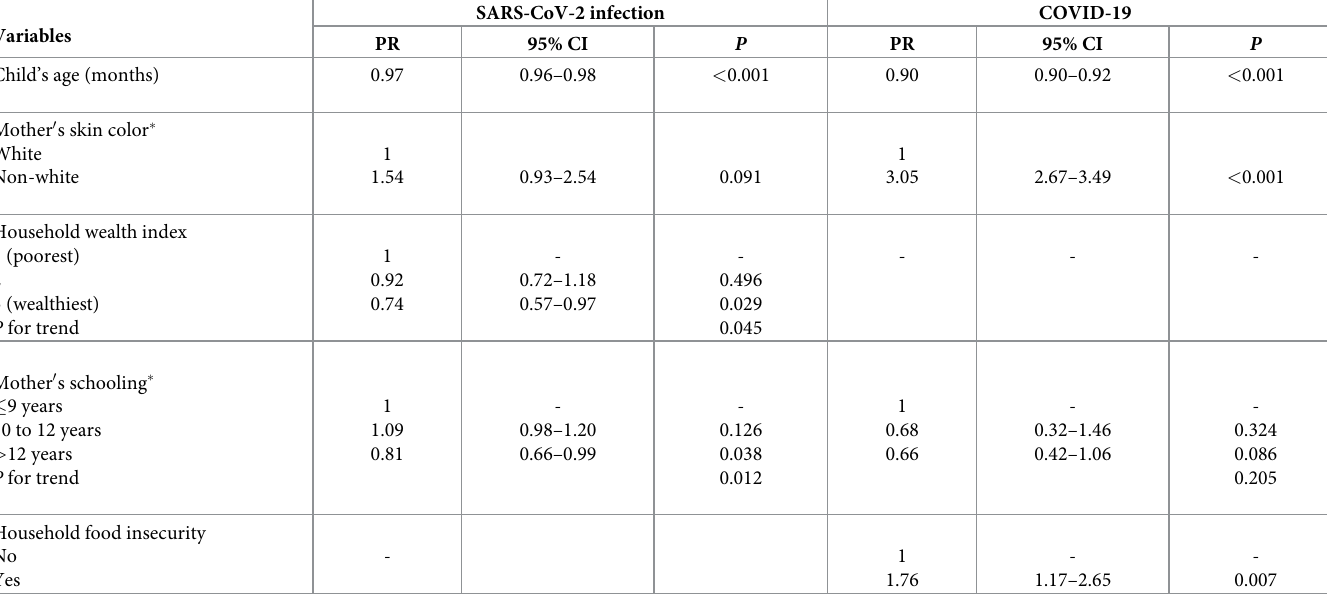
Clinically apparent COVID-19 was defined in children with SARS-CoV-2 antibodies who reported at least one of the following symptoms/signs: cough, shortness of breath, and loss of taste or smell.